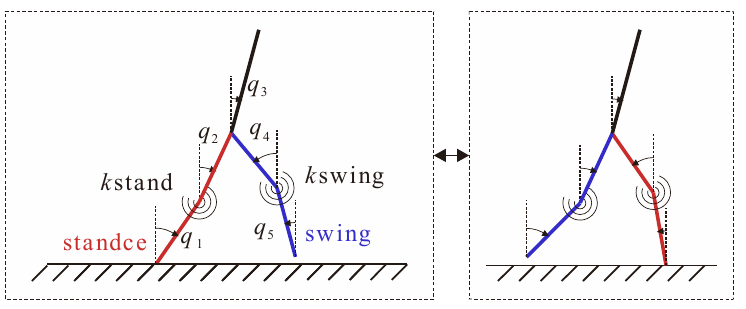
Figure 5. Structure-varying topology of the biped robot during walking.